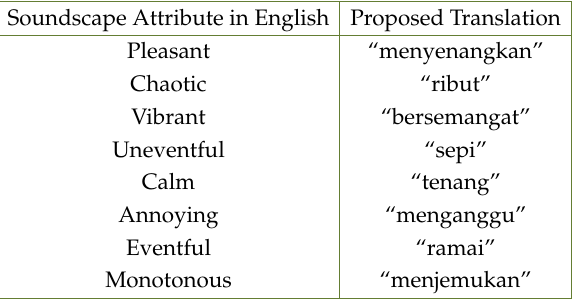
Table 2. Standard Soundscape Attributes in Indonesian. Soundscape Attribute in English Proposed Translation